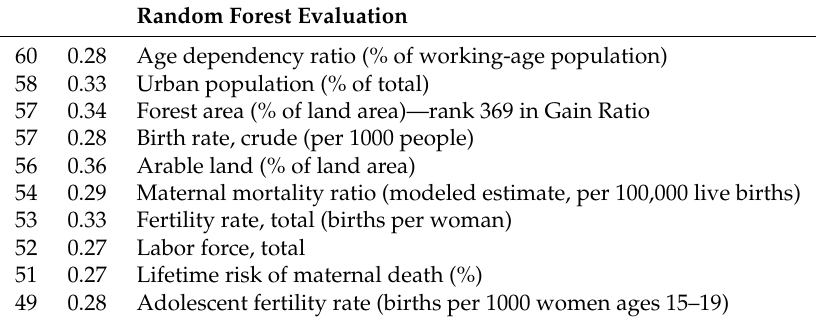
Table 6. Attribute evaluation with random forest. The first column shows the numbers of trees, the attribute was used in. The second column shows the average reductions of entropy that is obtained by the use of this attribute (cf. Section 2.3.3 - Random Forest Evaluation). The last column shows the name of the attributes.